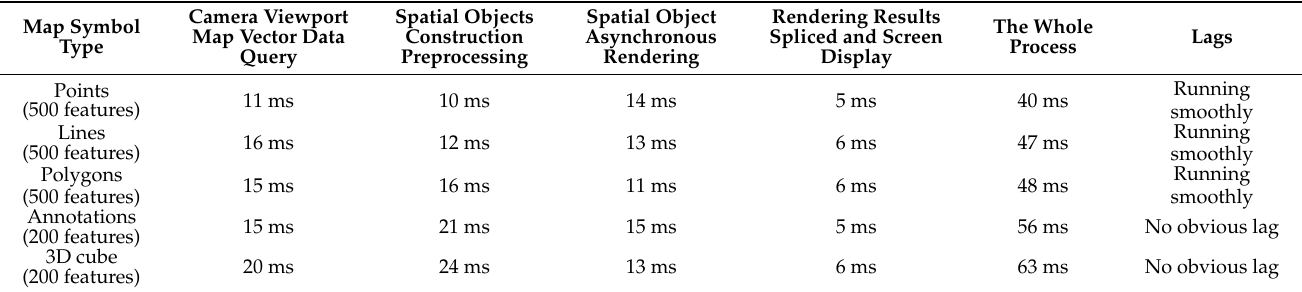
Table 2. Sub process time test of various rendering algorithms.